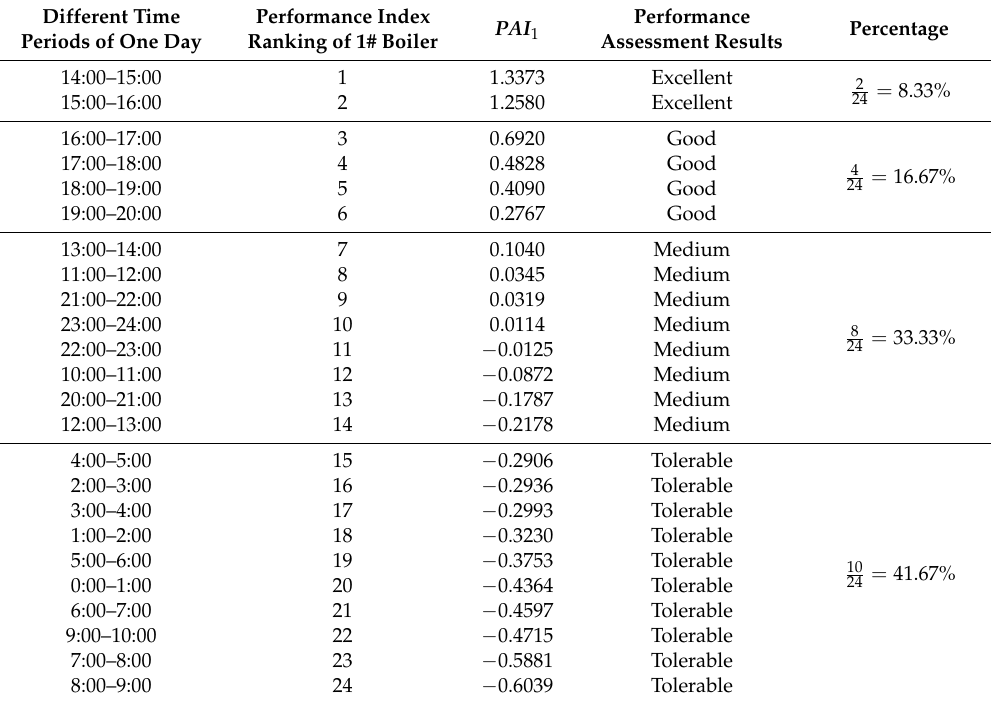
Table 6. The results and ranking of performance assessment index PAI 1 . (1# Boiler combustion control process). Different Time Periods of One Day